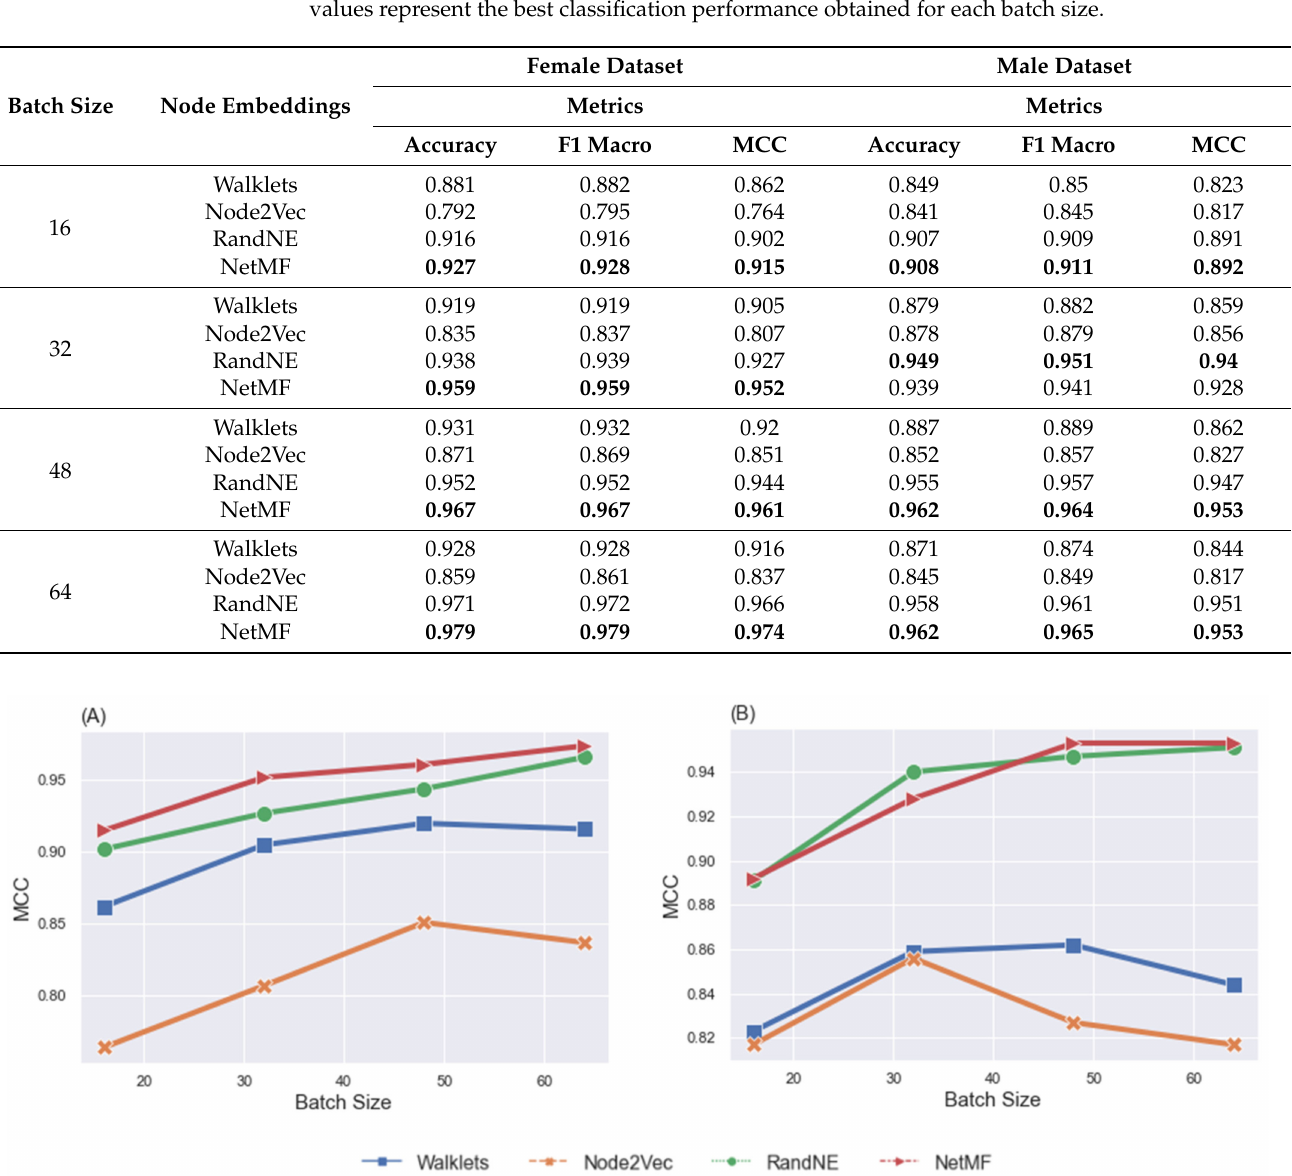
Figure 4. MCC comparison of the GCN model, taking into account the effects of node embedding methods and batch sizes, by using female task fMRI data ( A ) and male task fMRI data ( B